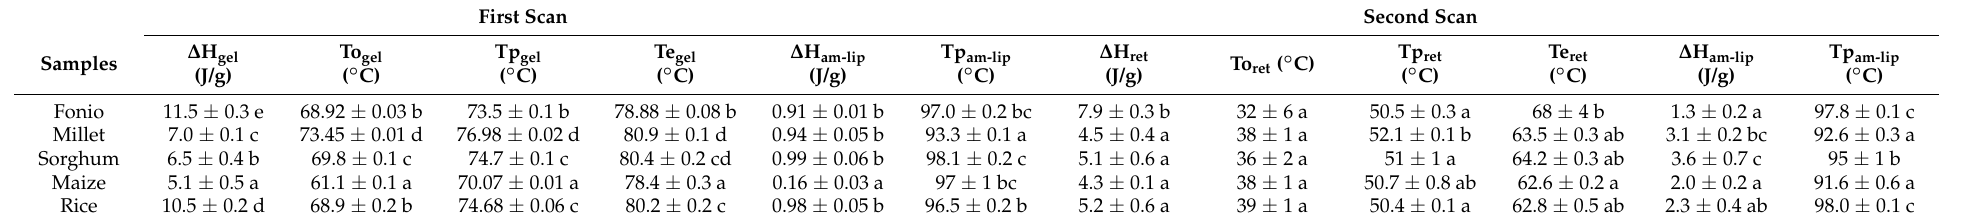
Table 5. Thermal properties of fonio, millet, sorghum, maize, and rice flours. First